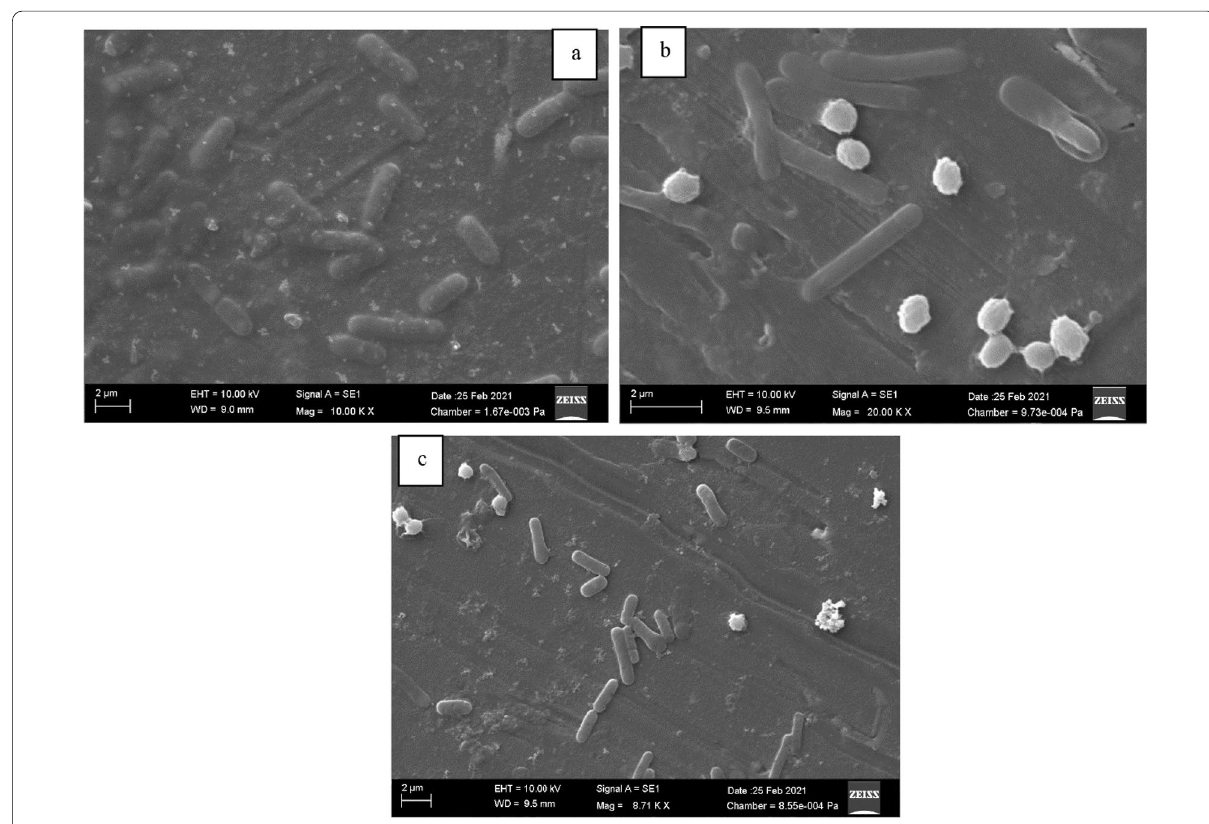
Fig. 1 Scanning electron microscope images of the bacteria GV3 ( a ), GV5 ( b ) and GV7 ( c